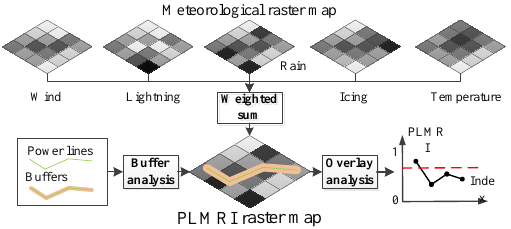
Figure 5 Workflow of PLMRI value extraction